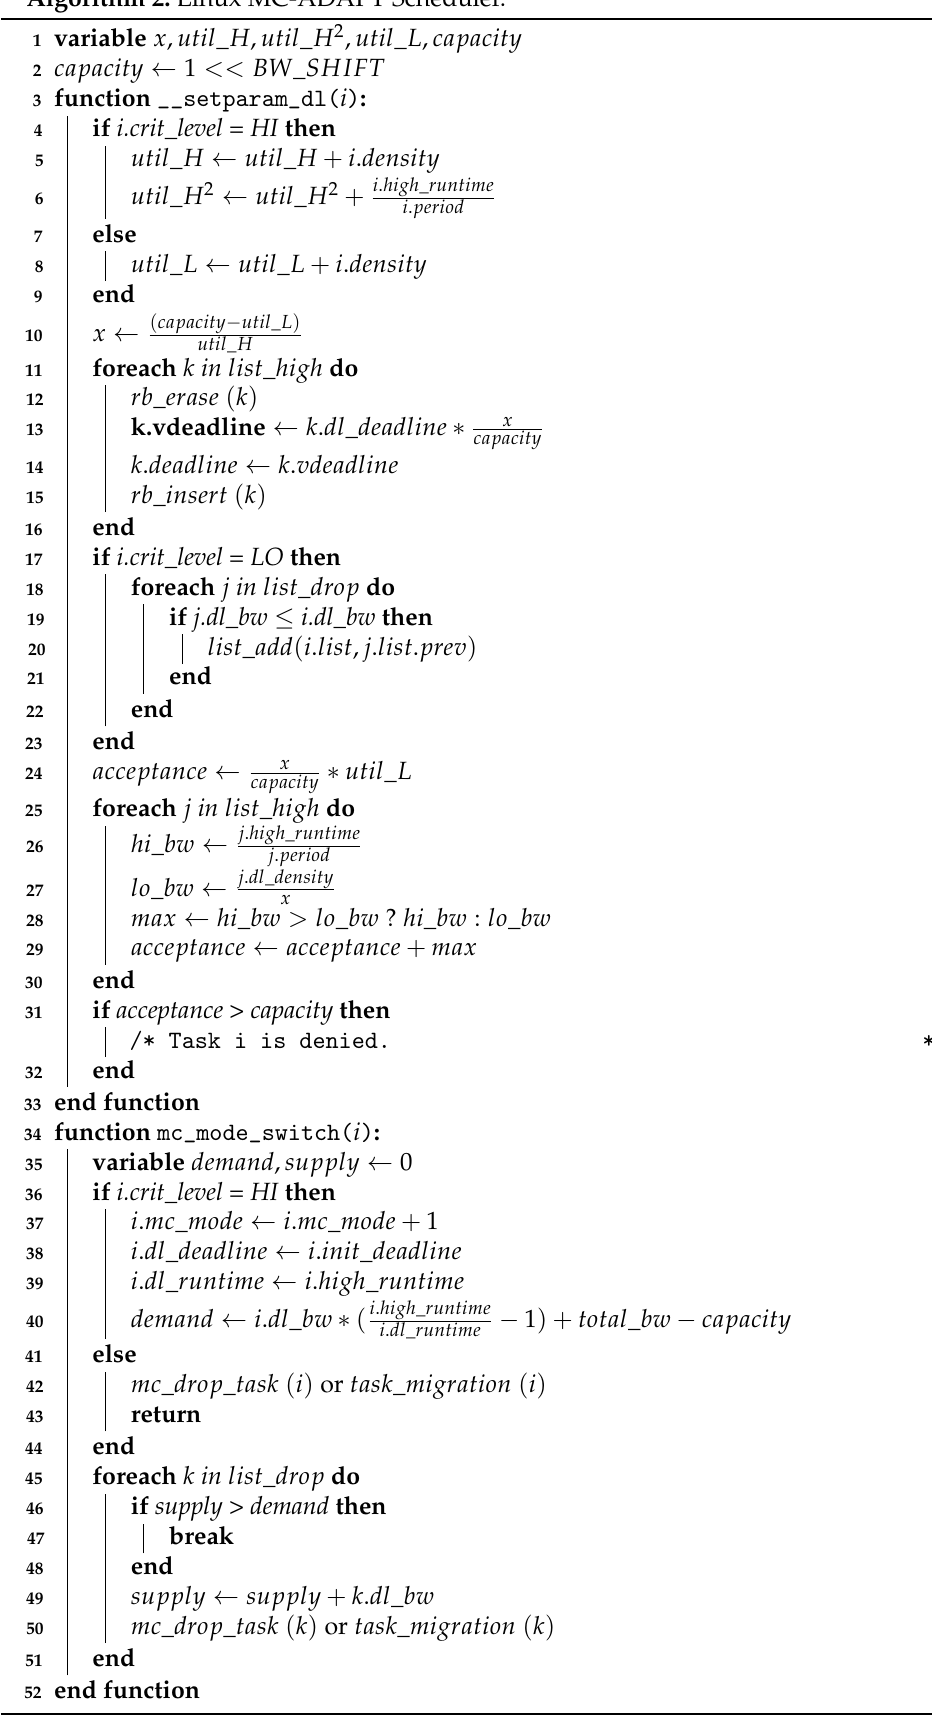
Algorithm 2: Linux MC-ADAPT